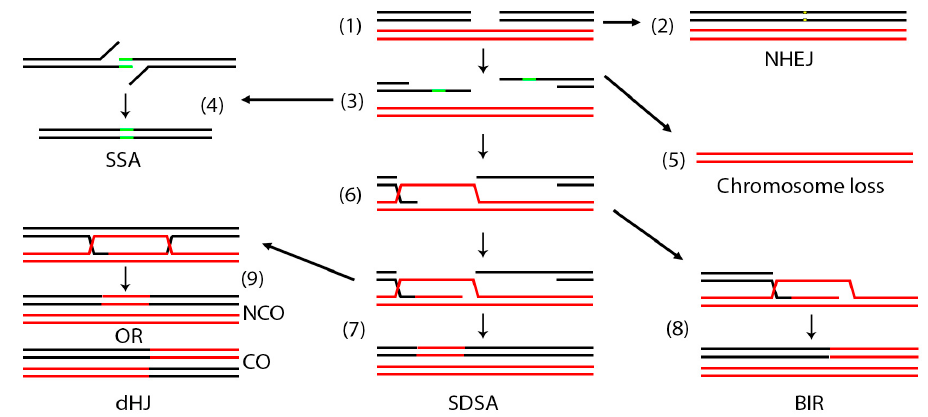
Figure 1. Cellular pathways of mitotic DNA double strand break repair. In a diploid cell, a DSB may occur in one of the two homologous chromosomes (1). The DSB may be repaired by non-homologous end joining (NHEJ) (2). When repair occurs by homologous recombination (HR), the DSB is first resected (3) to expose areas of single stranded DNA. If direct repeats (green areas) exist on the same chromosome, the break may be repaired by single strand annealing (SSA) (4). If homology is not found, the chromosome may be entirely lost (5). When homology is found elsewhere, the broken ends may invade this region (6). In synthesis dependent strand annealing (SDSA) (7) the invading strand may copy a small region then release and re-anneal. In break induced replication (BIR) (8) the invading strand may copy to the end of the red chromosome. In this case the right part of the broken black chromosome is lost. Occasionally, a more complex double Holiday junction (dHJ) may be established (9), the resolution of which can result in crossovers (CO) or non-crossovers (NCO). Schizosaccharomyces pombe (fission yeast) diverged from Saccharomyces cerevisiae (budding yeast)